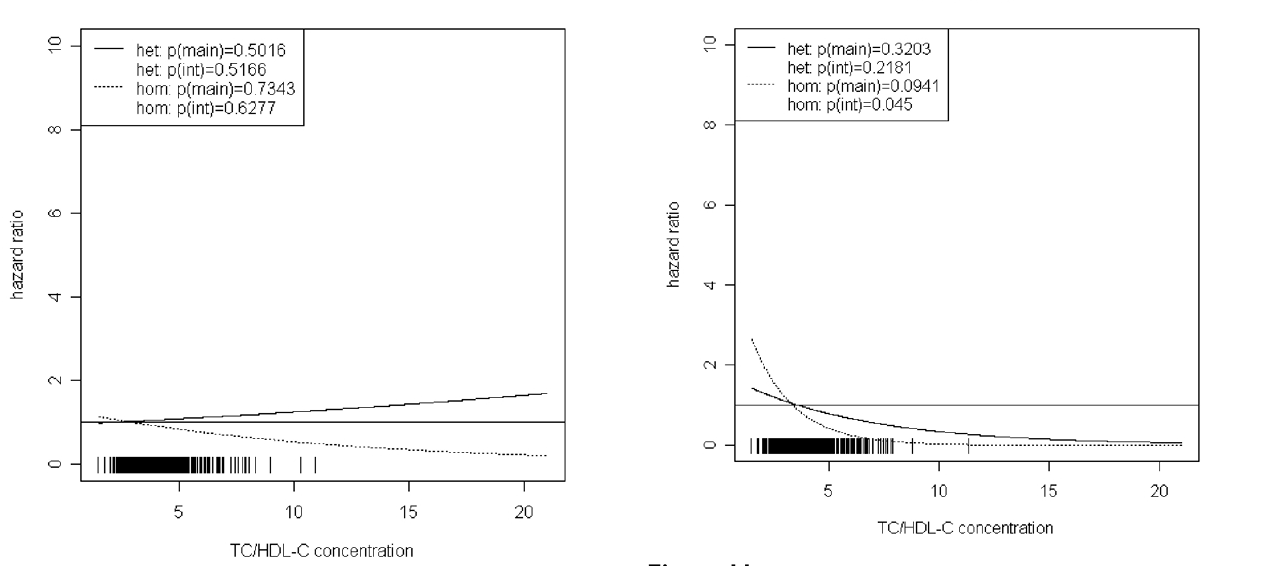
Figure 11 Hazard ratios of incident type 2 diabetes related to the respec- tive TC/HDL-C concentration in women for rs1927911 . Dashed lines represent subjects who are homozygote for the minor allele, while continuous lines show heterozygotes. Small bars at the x-axis indicate TC/ HDL-C concentrations of patients with at least one copy of the minor allele.